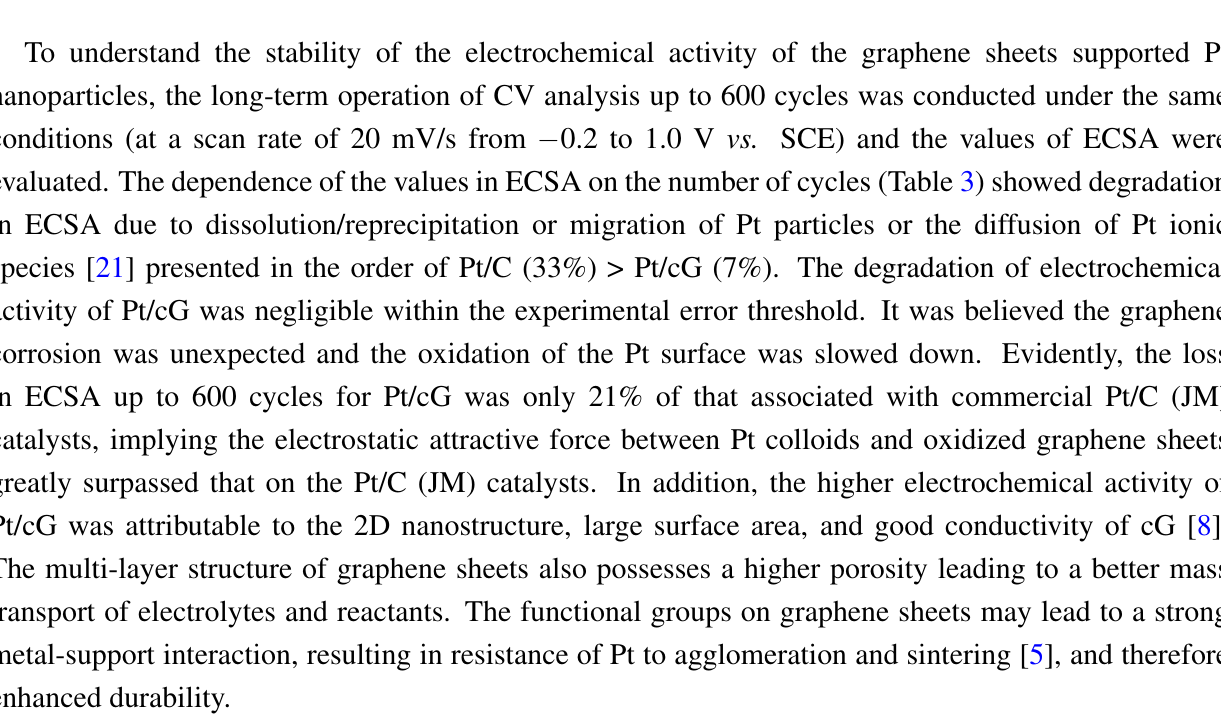
Figure 7. Cyclic voltammograms and changes in ECSA for all samples.